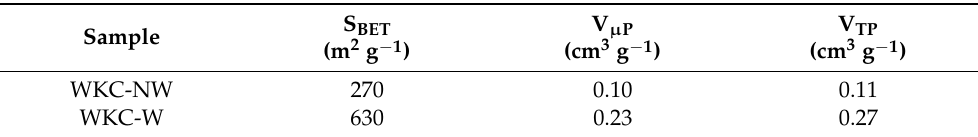
Figure 4. Nitrogen adsorption–desorption isotherms at 77 K for WKC-NW and WKC-W ( a ) and their micropore size distribution ( b ). Table 1. Textural properties for WKC-NW and WKC-W (SBET: specific surface area, VTP: total pore volume, V µP : micropore volume).